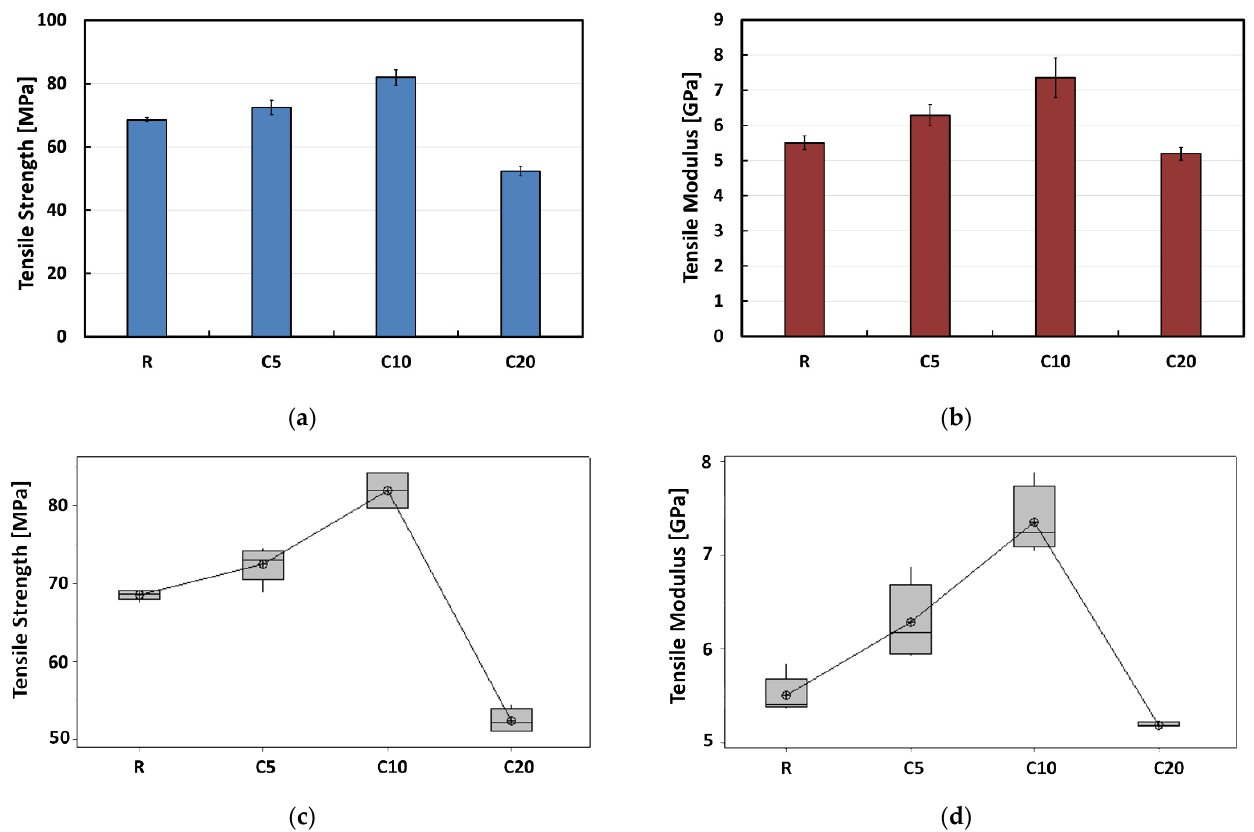
Figure 2. Tensile properties ( a , b ) bar chart and ( c , d ) box plot for each treatment condition.